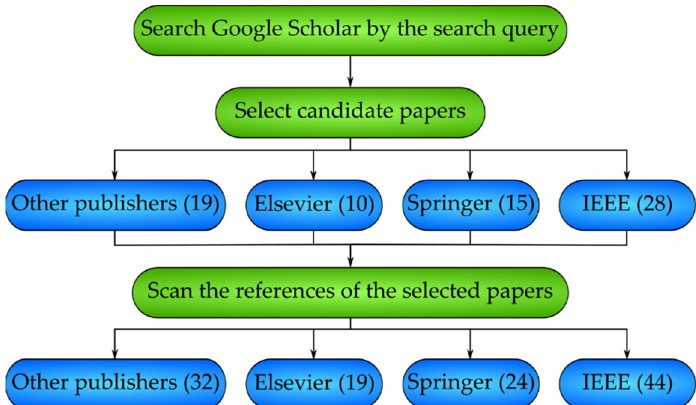
Figure 1. The statistics of the selected papers are categorized according to their publishers.